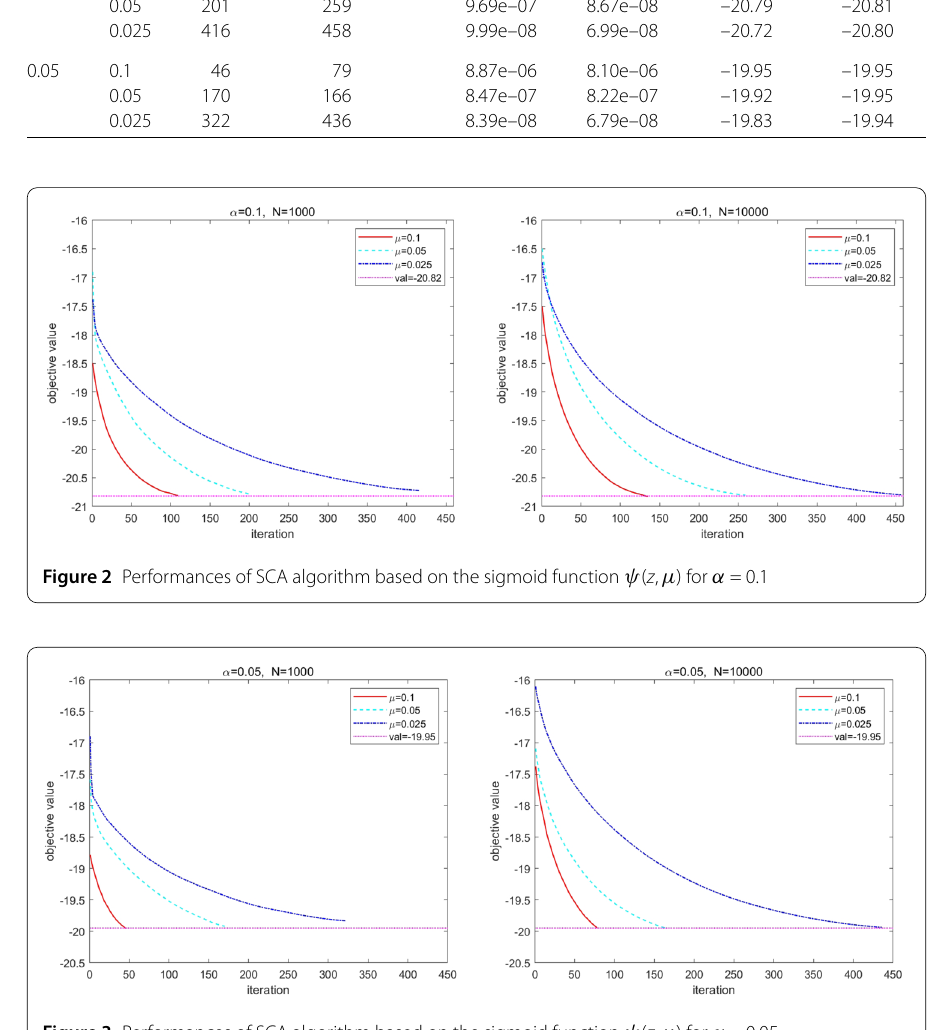
Figure 3 Performances of SCA algorithm based on the sigmoid function ψ ( z , μ ) for α =